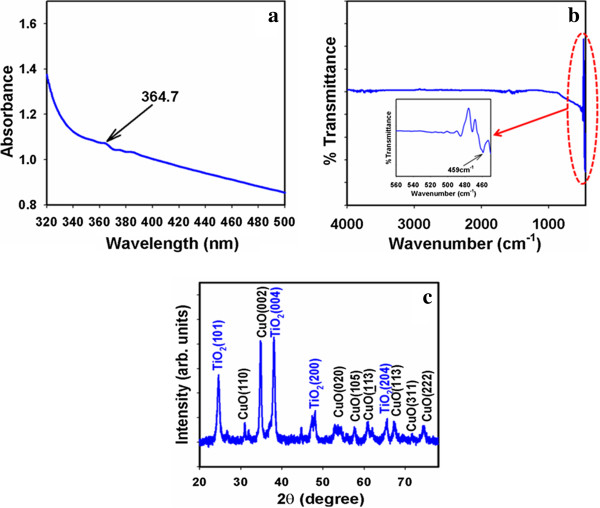
(a) UV/visible spectroscopy and (b) FT-IR spectroscopy, and (c) powder X-ray diffraction pattern of calcined CuO-TiO2 nanosheets materials.